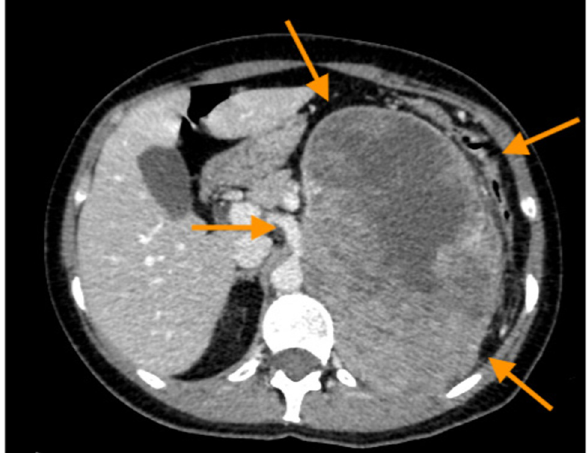
Figure 1: CT - scan, the imaging revealed a heterogeneous retroper - itoneal mass of 17 cm in diameter containing necrotic and hemor - rhagic areas, at the level of the superior left renal pole in fi ltrating partially the diaphragm ( arrows ) .